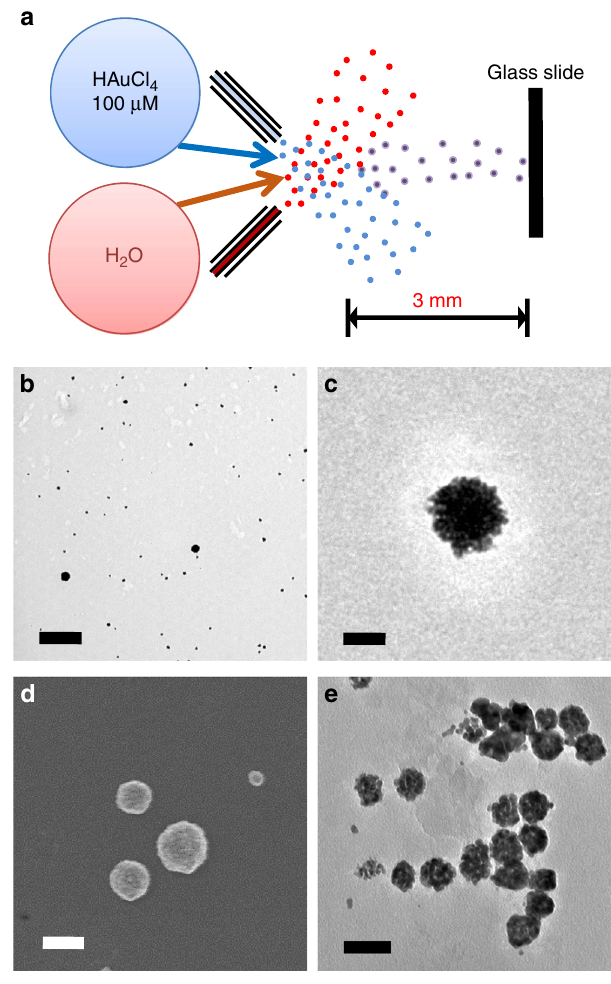
Fig. 2 Reducing-agent-free synthesis of AuNPs in the microdroplets with no externally applied charges. a schematic of the experimental setup for reducing-agent-free synthesis of AuNP in the microdroplets. Scale bar is 1 µ m. b , c TEM images of the synthesized AuNPs and AuNP aggregates. d SEM image of the AuNP aggregates. e TEM image showing an intermediate aggregated status of AuNP aggregates. Scale bars for b – e are 50